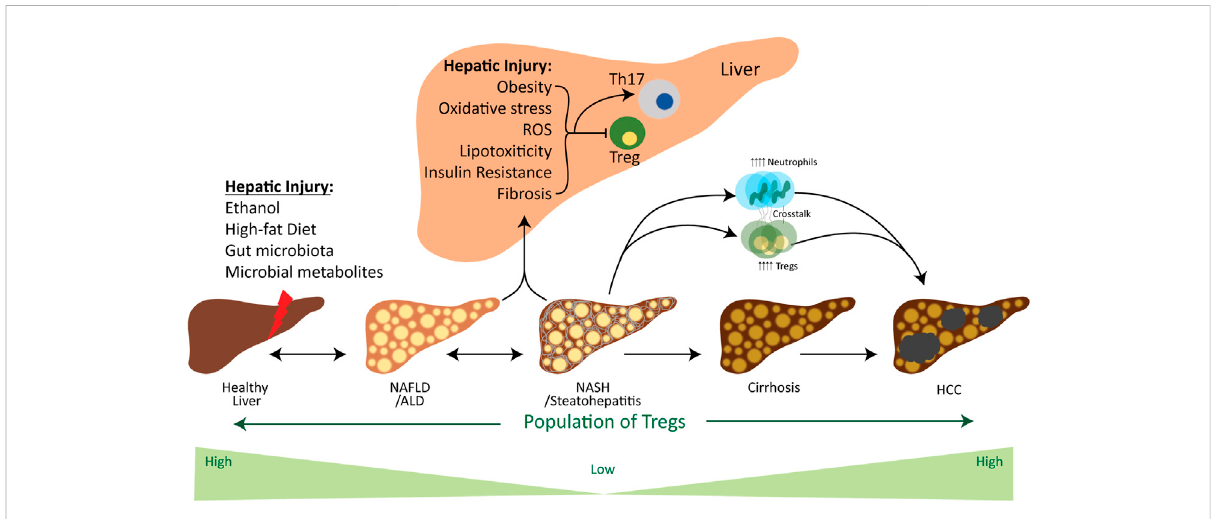
FIGURE 2 In fl uenceoffactors involvedinthechronicliverdiseasespectrumontheTregcells.Hepaticinjuryiscausedbyvariousenvironmentalstressors, includingethanol,ahigh-fatdietandgutmicrobiotaandtheirmetabolites.Thesestressorsinitiatethesimplesteatosisandleadtosteatohepatitisand cirrhosis in the liver, which fi nally progresses towards the tumor development. In the beginning, environmental stressors induce hepatic oxidative stress,ROS,lipotoxicity,insulinresistance, fi brosisandobesity,whicharethepathogenicfactorsforALD,NAFLD,NASHandHCC.Thesefactors considerably contribute in downregulating the activation of Tregs and their population for the development of steatosis and fi brosis. However, the progression of NASH towards the tumor development increases the population of Tregs to establish a pro-tumor microenvironment. Meanwhile, adaptive and innate immune systems communicate with each other through Tregs and neutrophils, which aid in the progression of NAFLD- associated HCC. Abbreviations: Treg, regulatory T cell; Th-17, T helper 17 cell; NAFLD, Non-alcoholic fatty liver disease; ALD, alcoholic liver disease; NASH, non-alcoholic steatohepatitis; HCC, hepatocellular